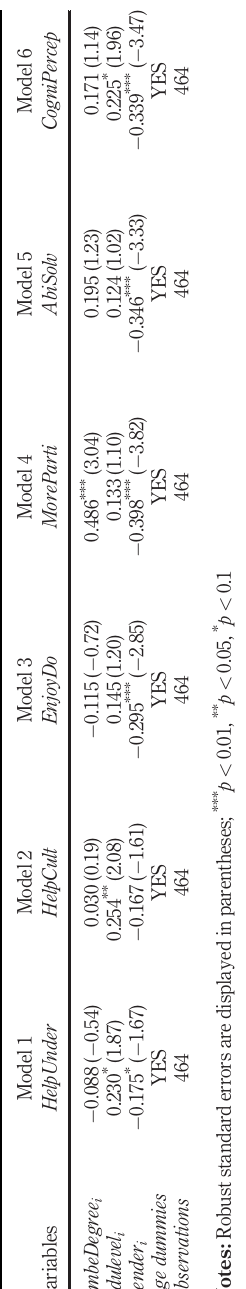
Table 7. Results the international student ’ individual